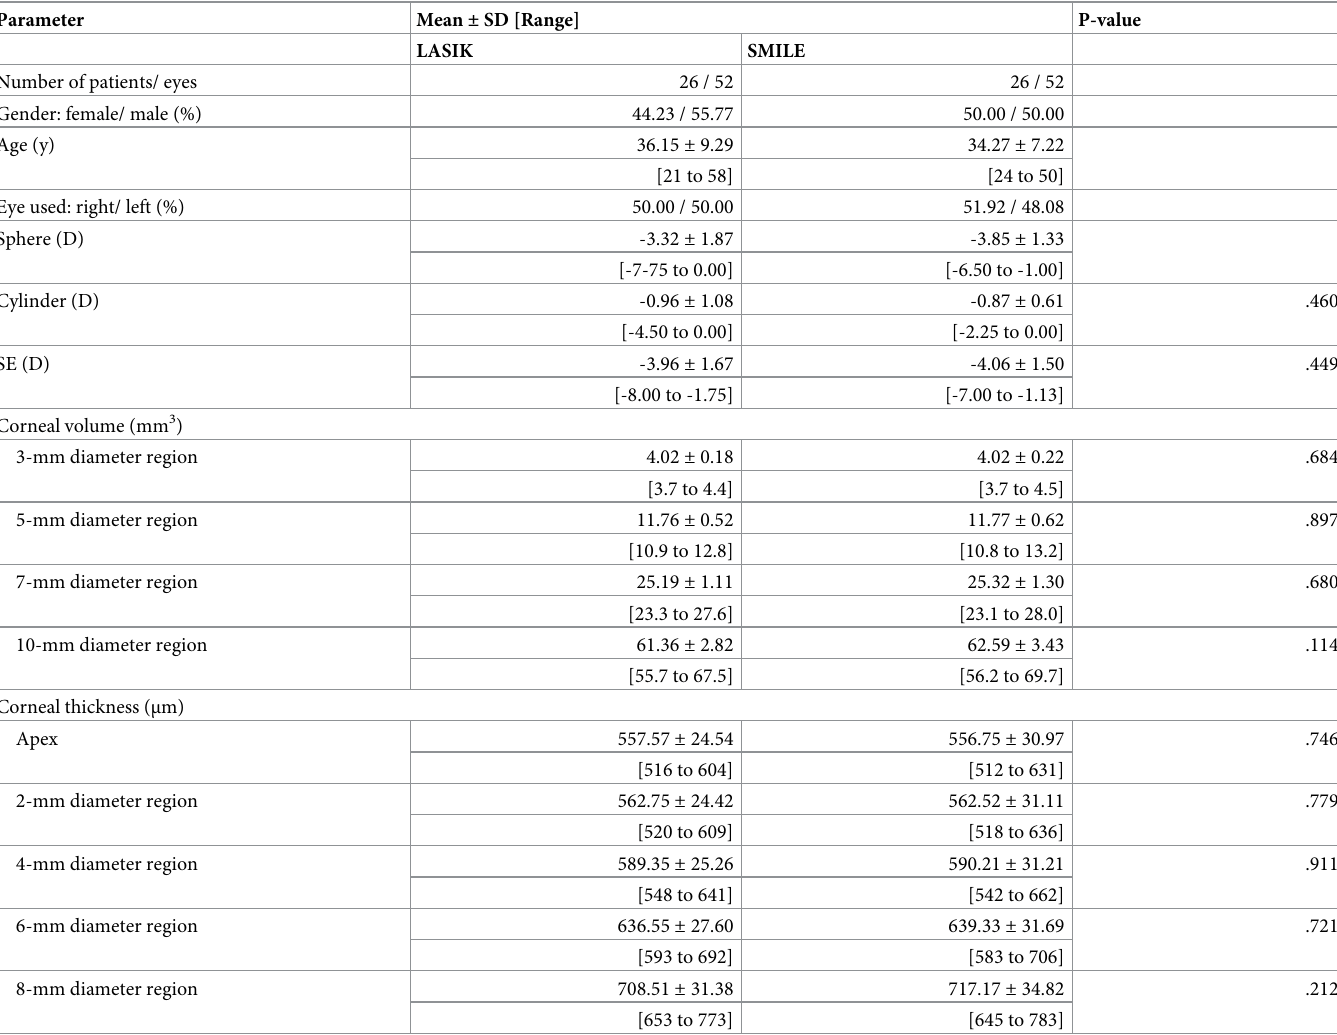
Table 1. Study population characteristics (n = 104).